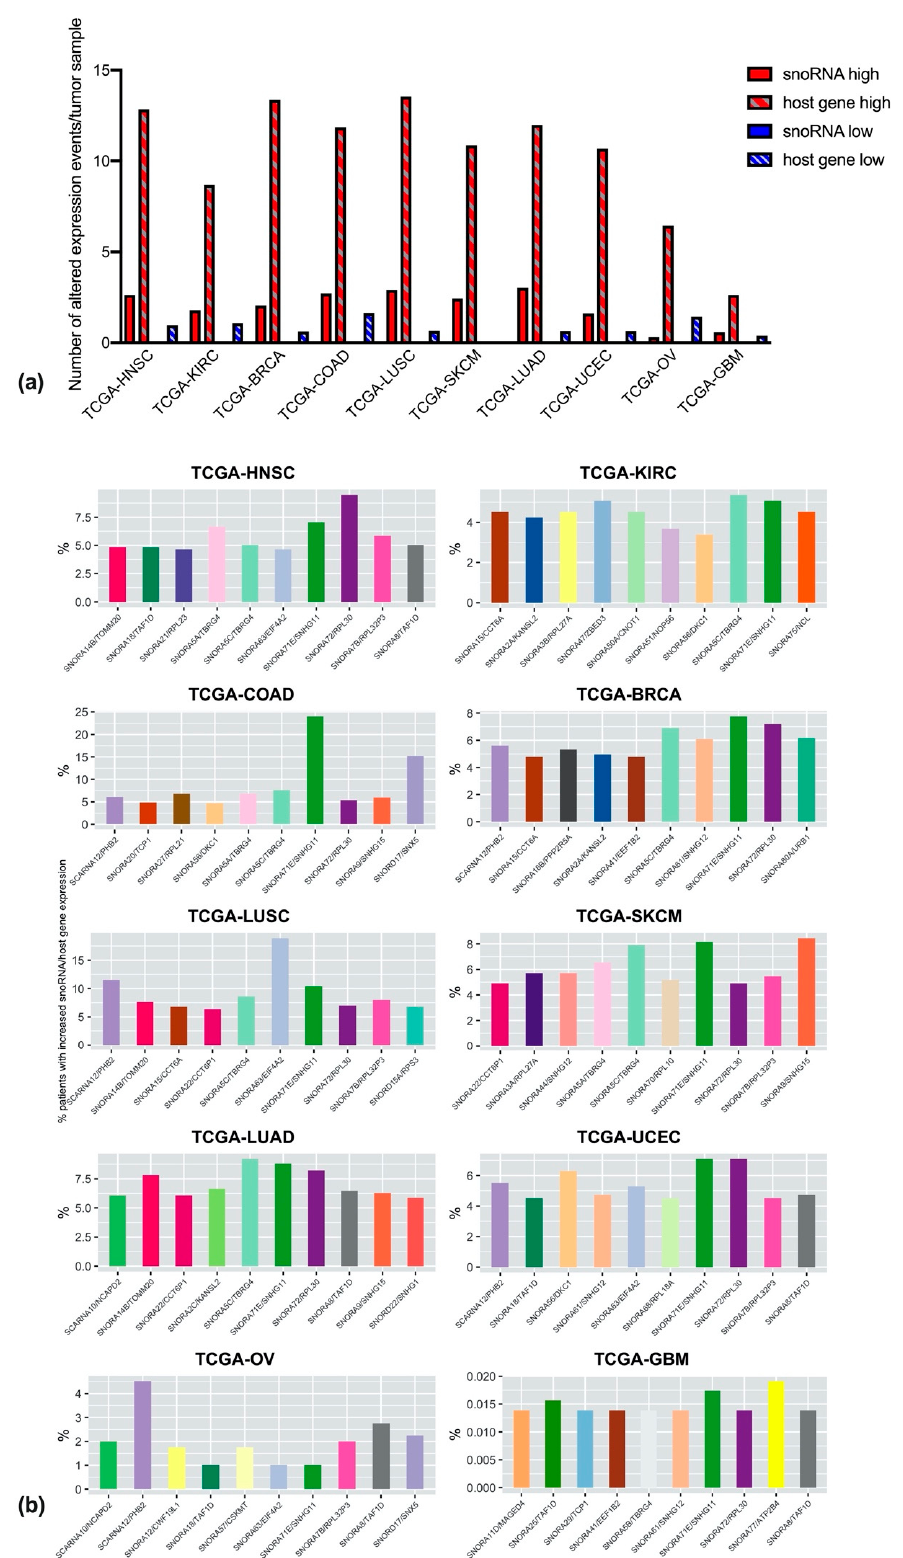
Figure 4. Alterations in gene expression for snoRNAs and host genes. ( a ) Number of expression alteration events, normalized per sample, and represented with di ff erent colors in case of higher expression (red), lower expression (blue), and further split into expression alterations only involving snoRNAs (filled bars) or involving host genes (textured bars). ( b ) Top snoRNA / host gene couples undergoing expression alterations in the ten di ff erent tumor types. For easier interpretation, couples recurring in di ff erent tumor types have been assigned the same bar colors, and colors are matched to those assigned in Figure